Question: What type of chart is this?
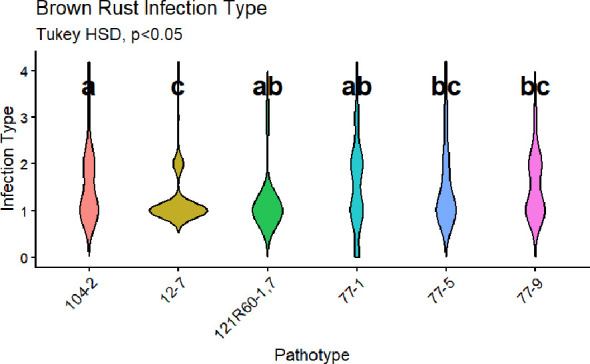
Answer: box